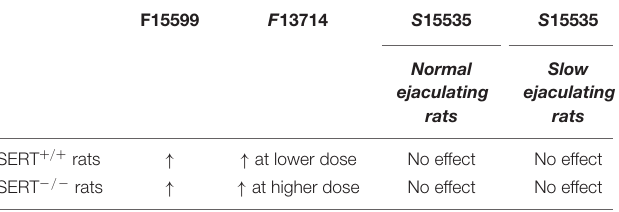
TABLE 4 | Overview of ejaculatory responses to 5-HT 1A receptor agonists in SERT + / + and SERT − / − -/